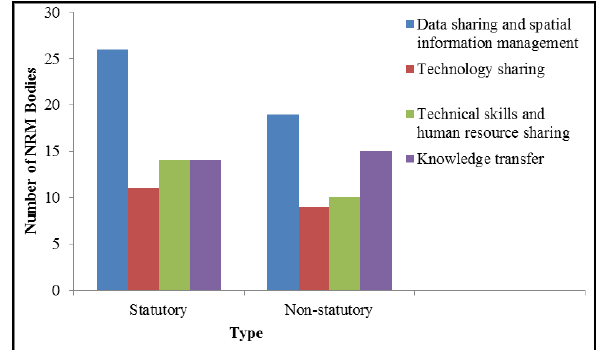
Figure 6: Area of